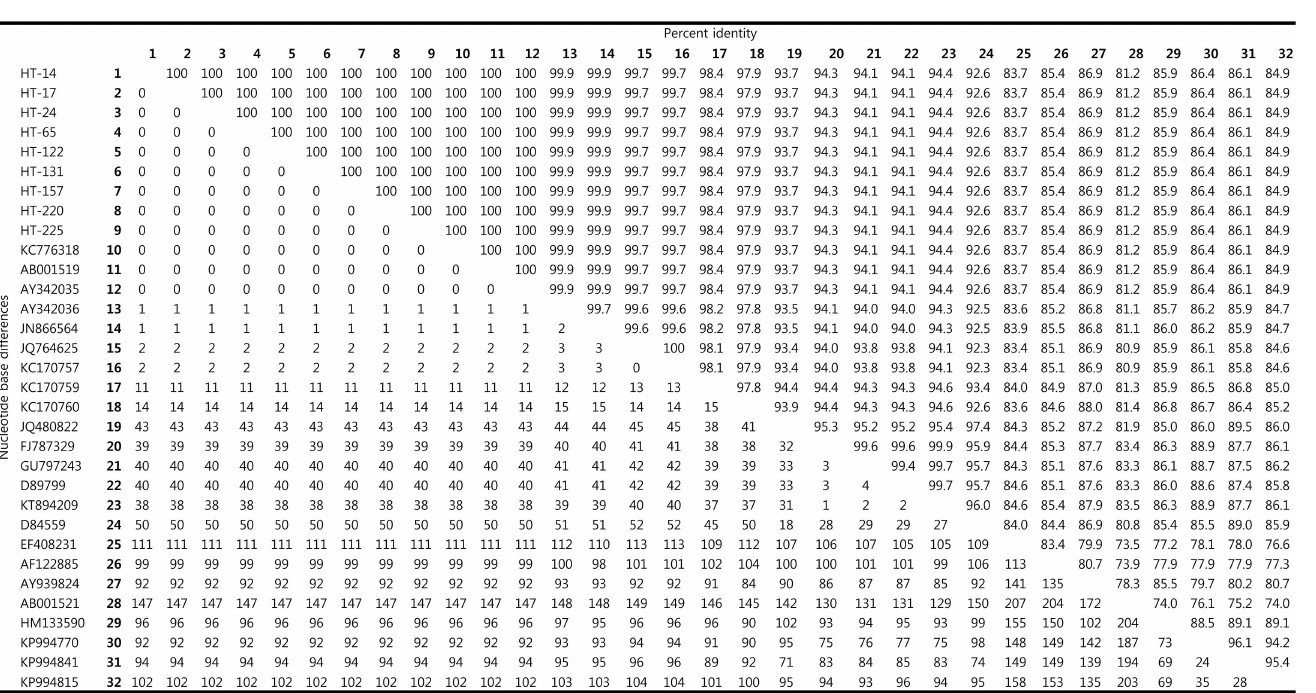
Fig 1. Comparison of Coxiella 16S rRNA nucleotide sequences. The upper matrix represents the percentage identity between Coxiella 16S rRNA sequences. The lower matrix representsthe number of nucleotidebase differences.